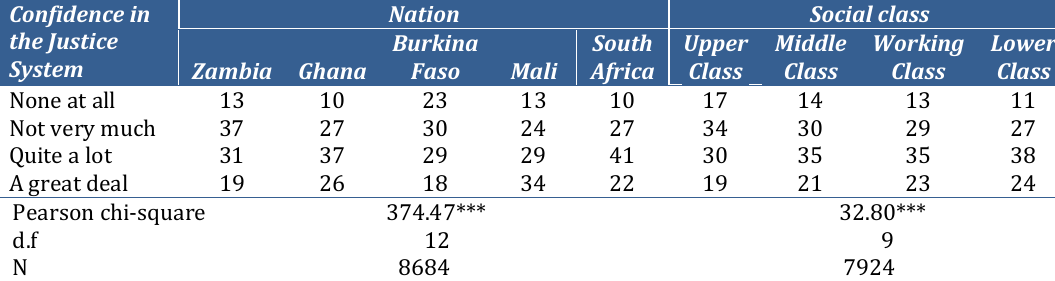
Table 2: Level of confidence in the Justice System by nation and social class Confidence